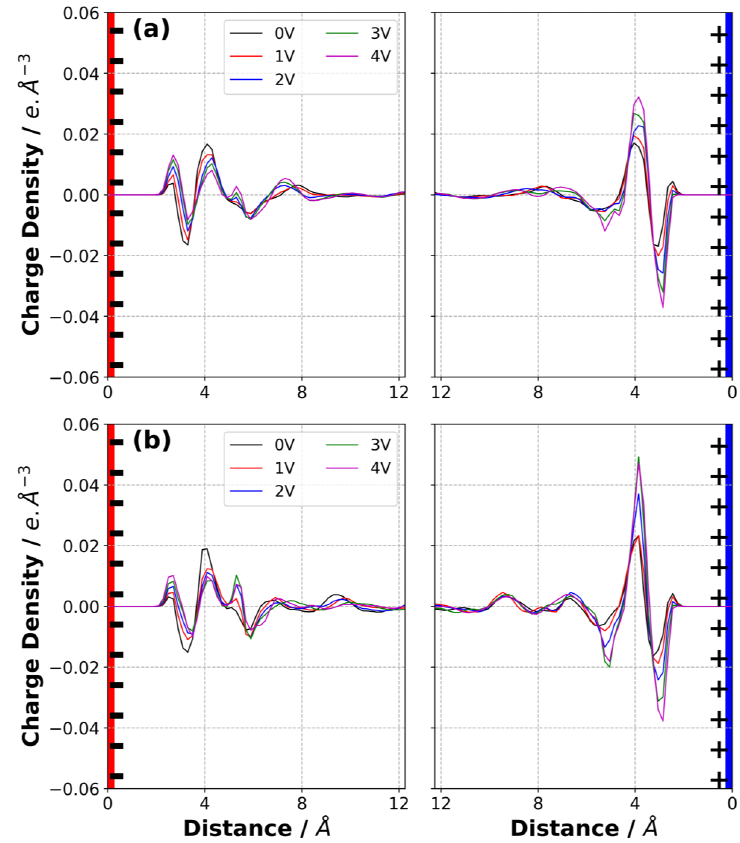
Figure 8. Charge density distribution of ( a ) [C 2 mim][NTf 2 ] and ( b ) [N 4,1,1,1 ][NTf 2 ] at 294 K at various potential difference applied across the simulation cell. The first and second columns represent the EDL in the vicinity of negative electrode and positive electrode,